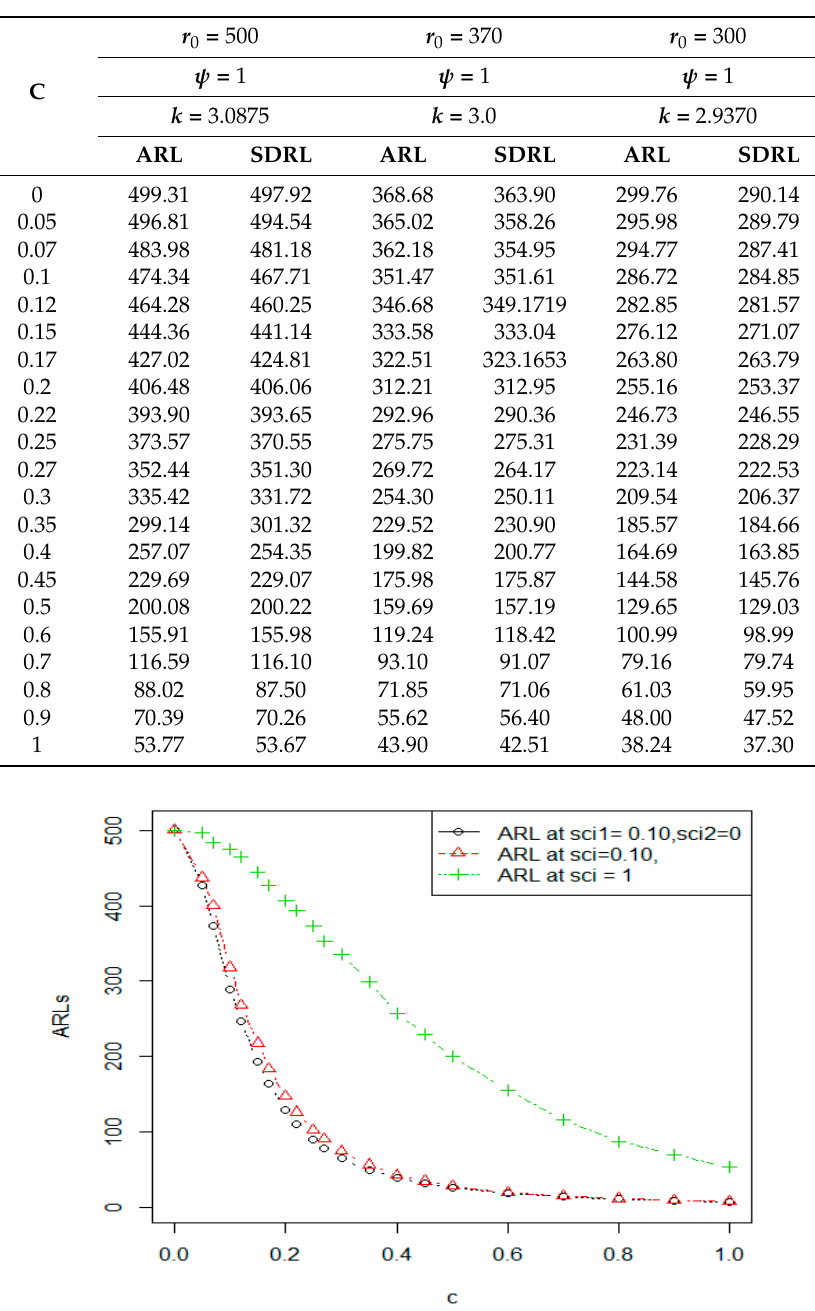
Table 7. The average run length (ARL), Standard Deviation of run length (SDRL) values of the Shewhart control chart for various shifts.